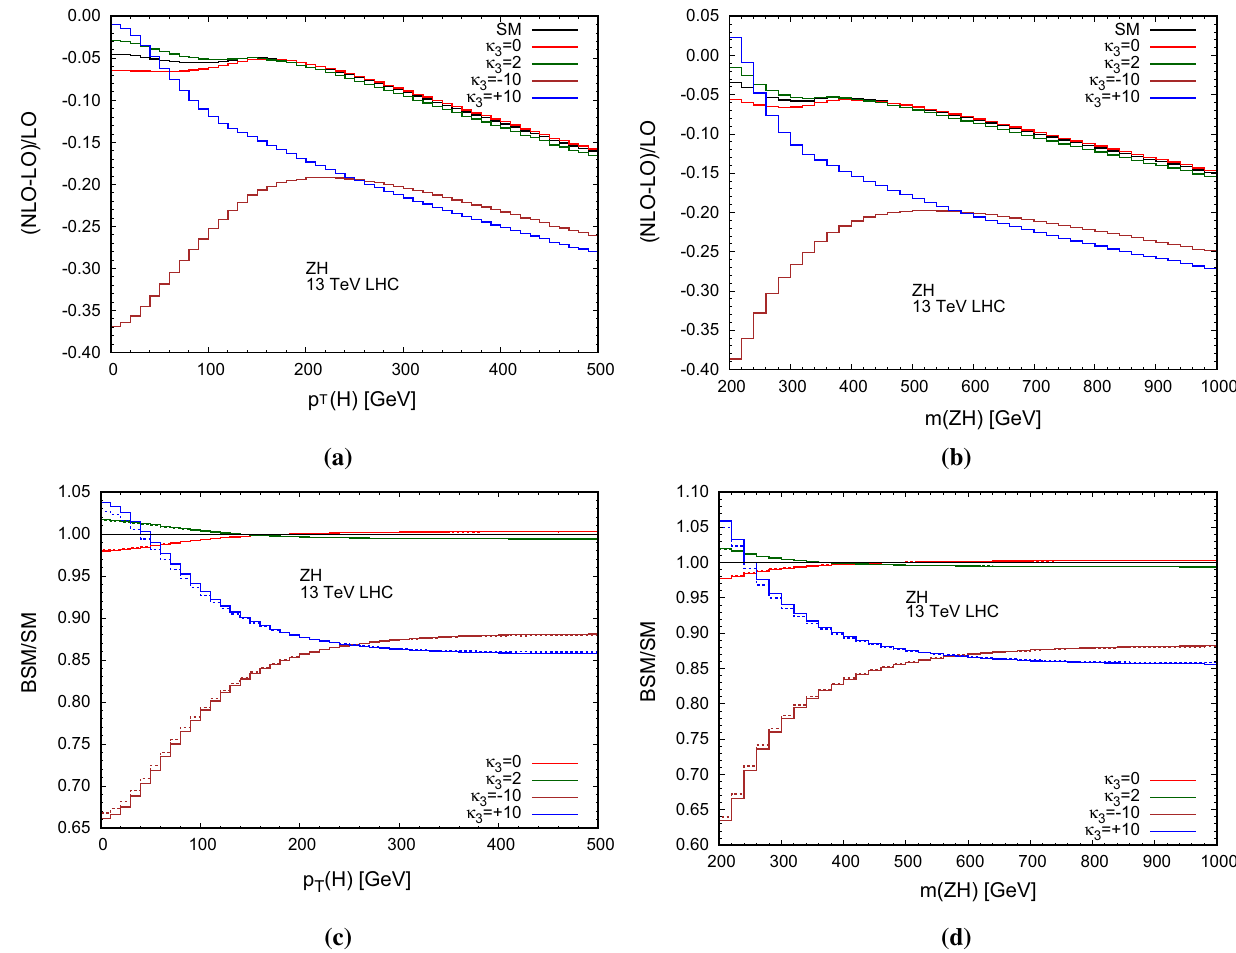
− σ )/σ LO LO ratio for different values of NLO